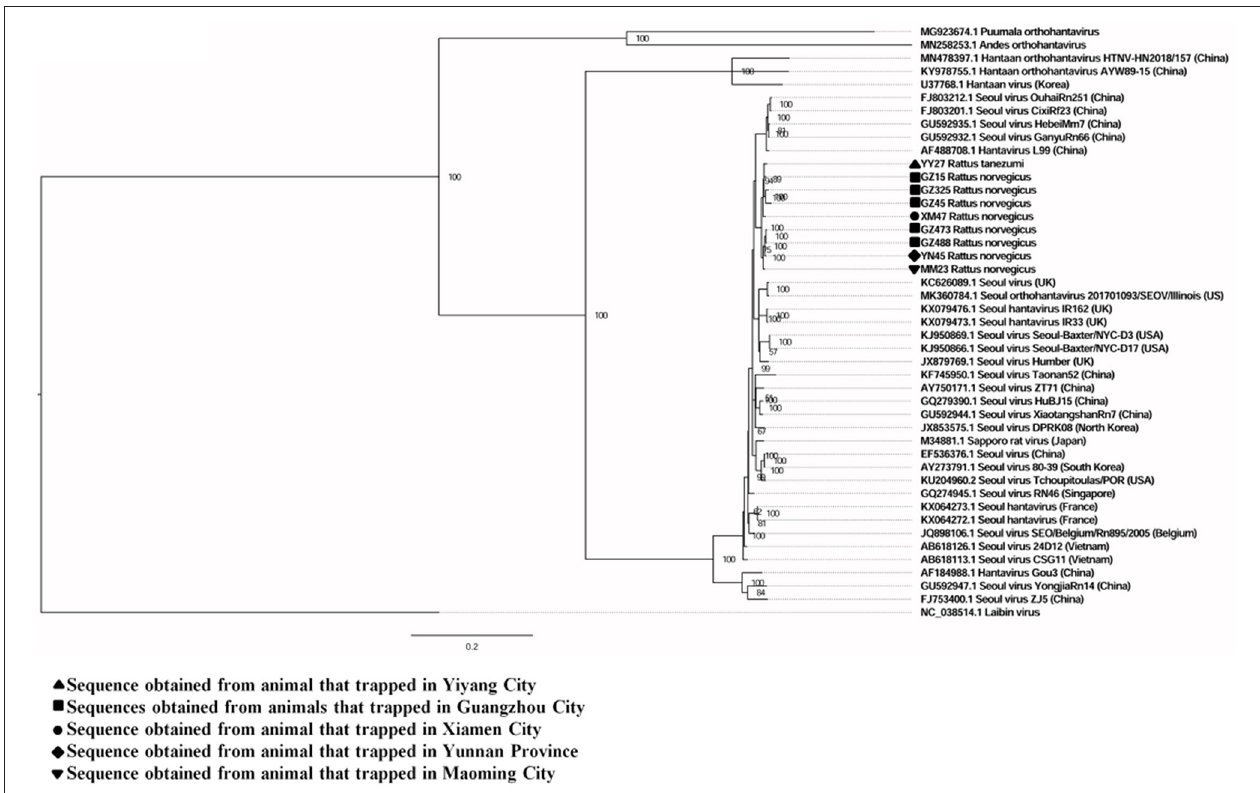
FIGURE 3 | Phylogenetic tree constructed using nucleotide sequences of the Seoul virus S gene obtained from rats. Thirty-five representative orthohantavirus sequences were included for comparison, and one Laibin virus sequence was set as the outgroup. The percentages of the posterior probability (PP) values are